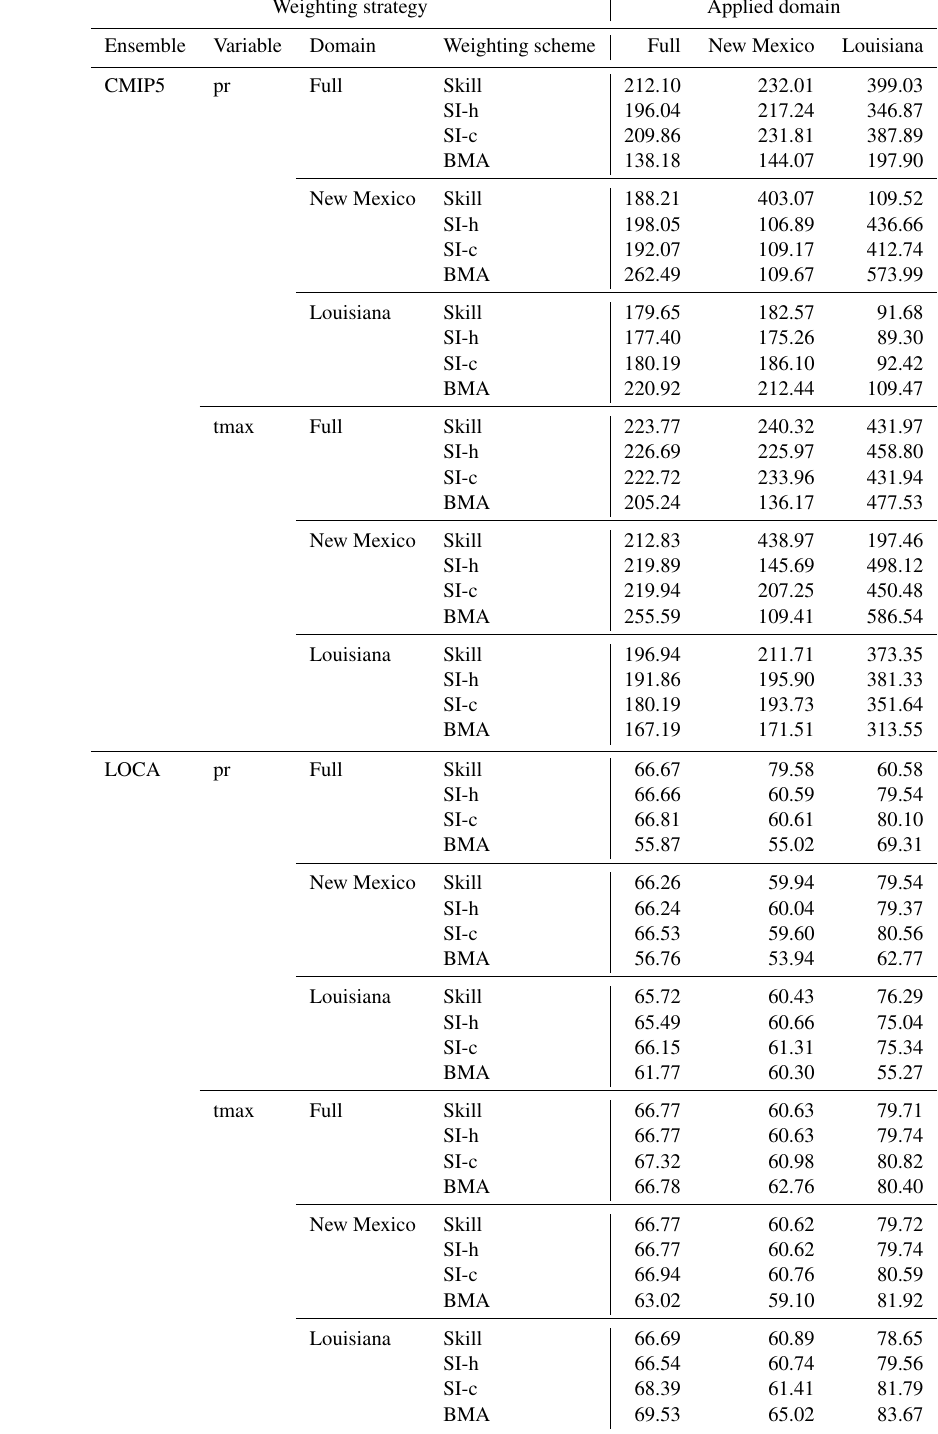
Table 2. RMSE (mm) of daily precipitation for each weighting strategy applied in all three domains. Weighting strategies include the weighting scheme and the ensemble, variable, and domain used to derive model